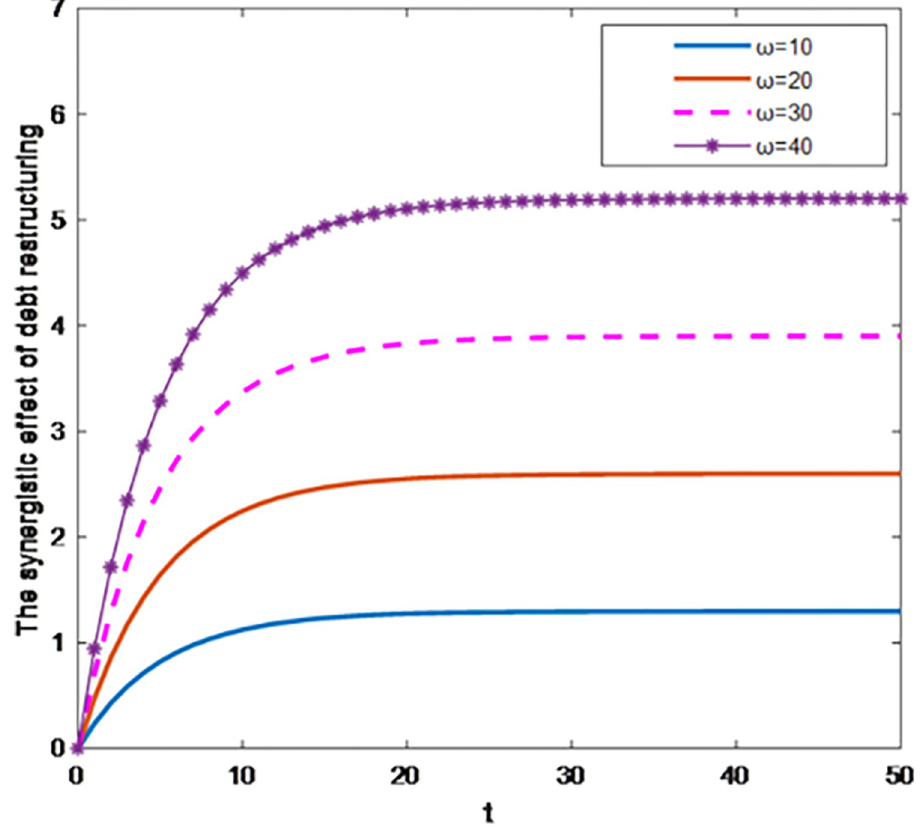
Fig 3. Effect of parameter ω on the synergistic effect of debt